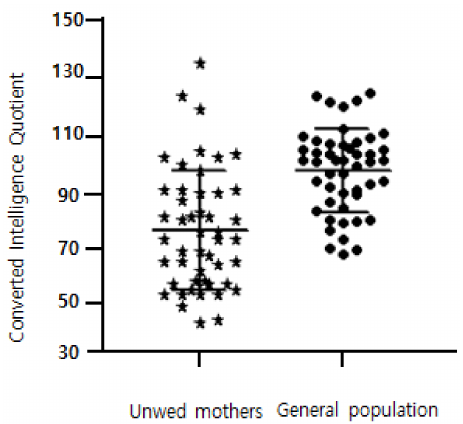
Figure 1. Difference in distribution of converted IQ scores between 48 unwed mothers and 48 of randomly generated